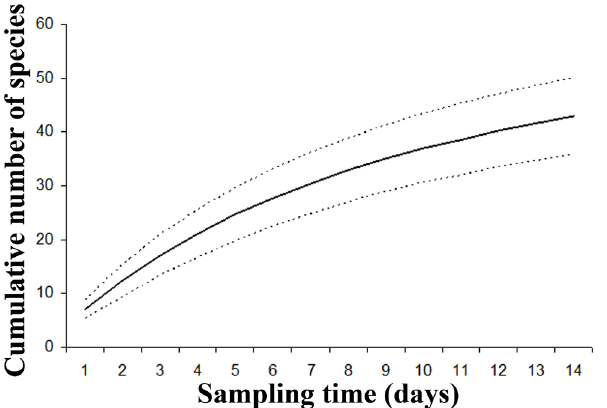
Figure 2. Sample-based species rarefaction curves for amphibian records in the Reserva Extrativista do Rio Gregório. Line represents the rarefied number of species per day, and dots are the correspondent standard errors.